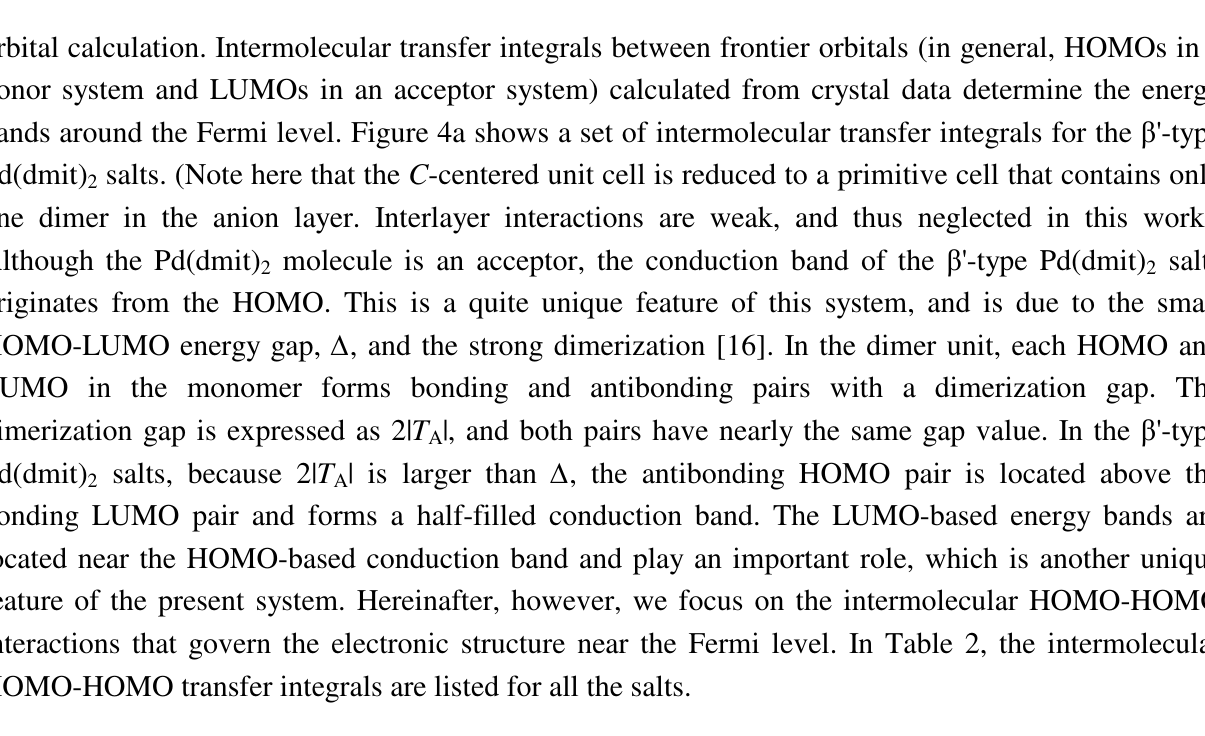
Figure 4. End-on projections of the dimer lattice in β '-type Pd(dmit)